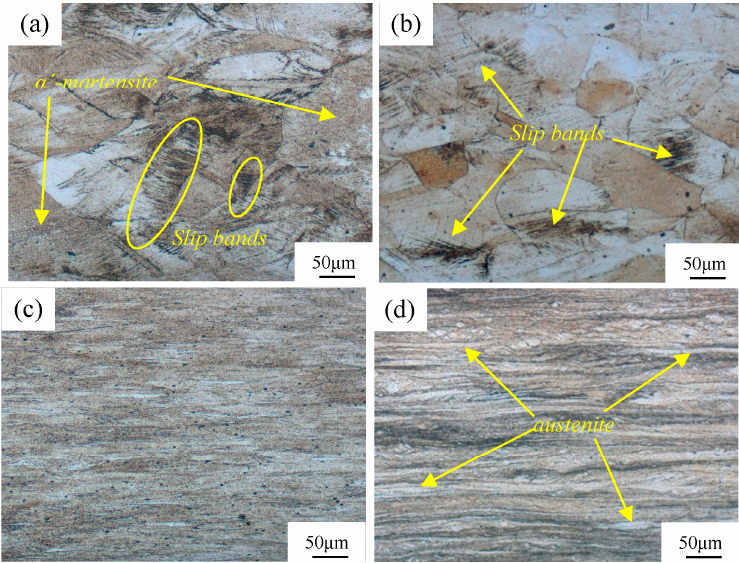
Figure 3. Metallographic structure of the 316LN austenitic stainless steel after CR and RTR: ( a ) CR-30%, ( b ) RTR-30%, ( c ) CR-90%, and ( d ) RTR-90%.